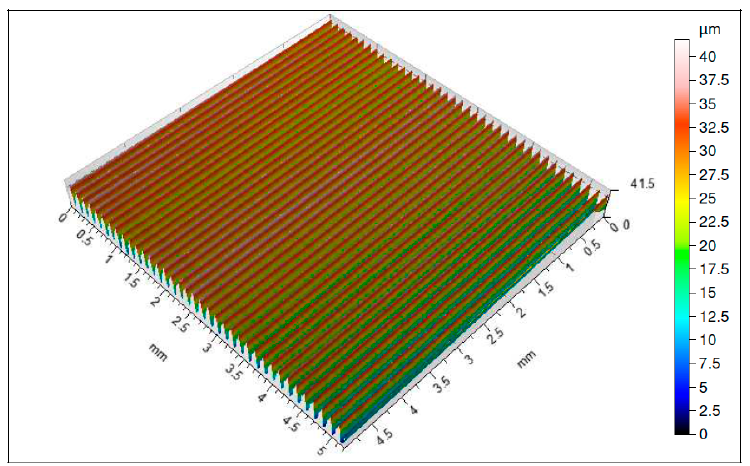
Figure 7. Topography of a surface obtained with an 1115-coated cutting insert.